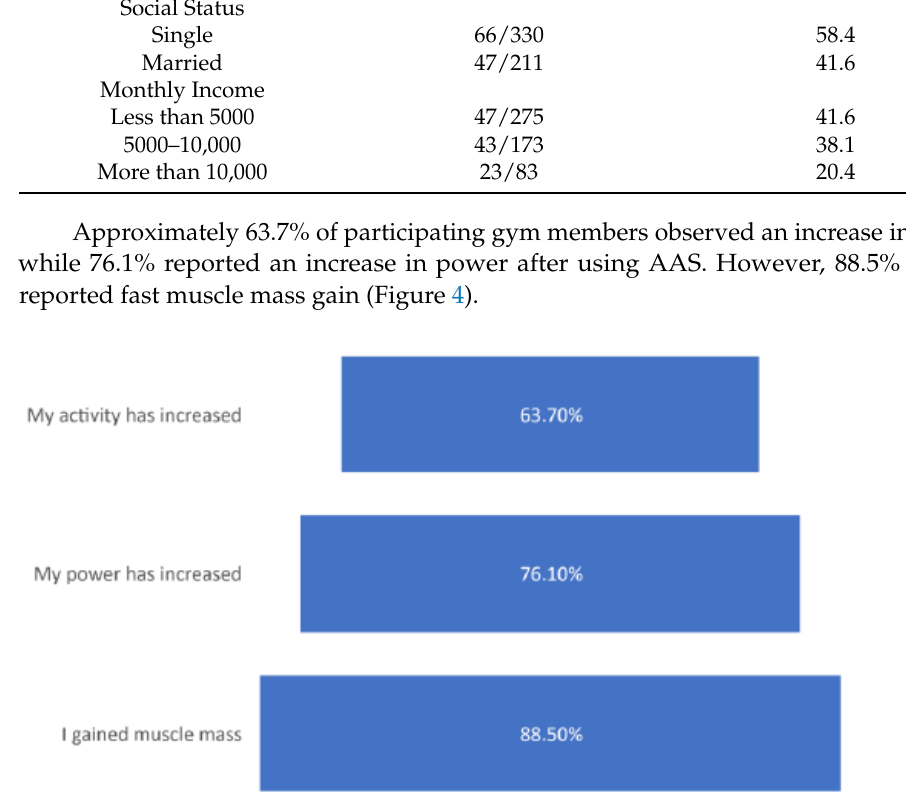
Figure 4. Reported advantages of using anabolic steroids.